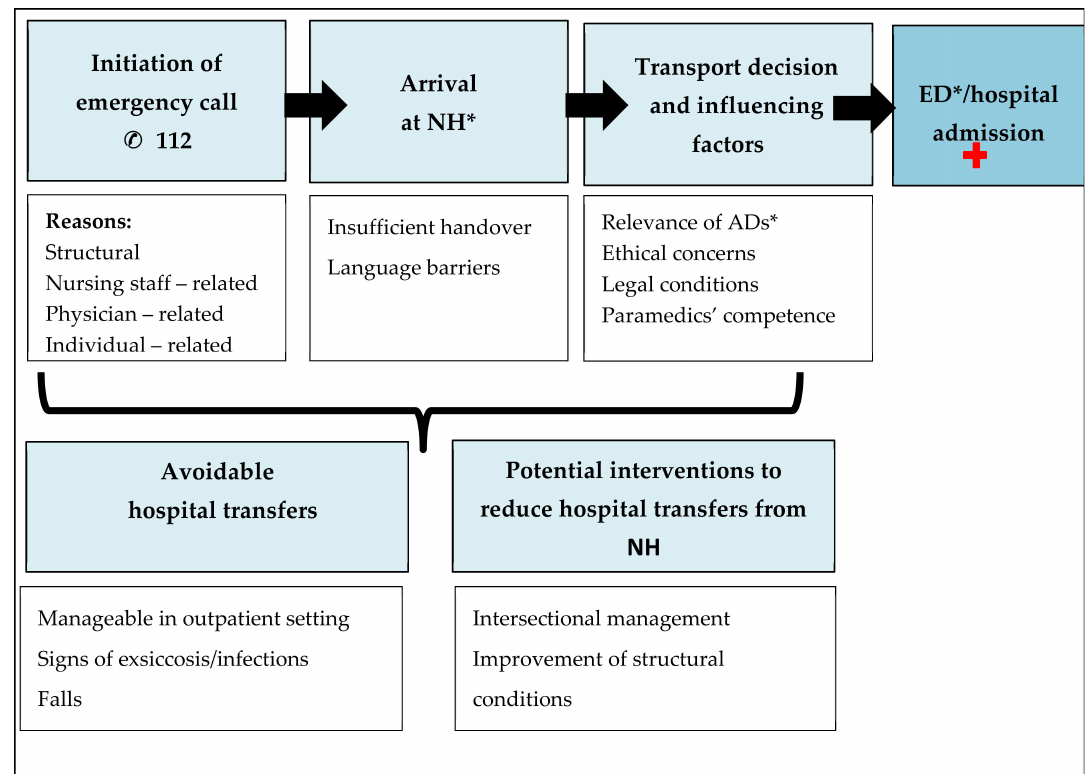
Figure 1. Main themes in the hospital transfer process: an overview of categories and